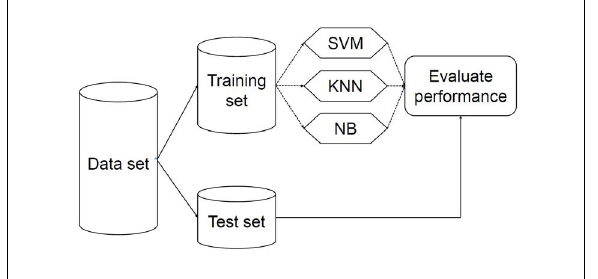
General framework of the methodology